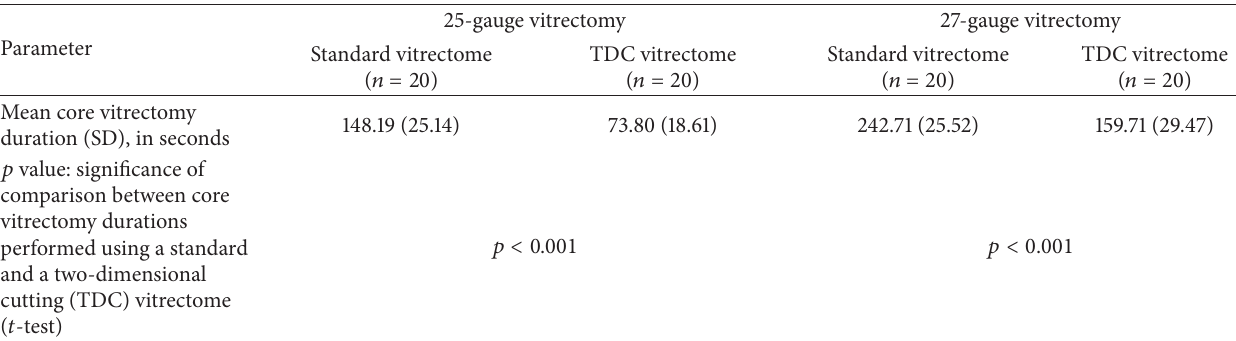
Table 2: Mean duration of core vitrectomy operating time for 27-gauge and 25-gauge surgeries utilizing either a standard single-cut or a TDC